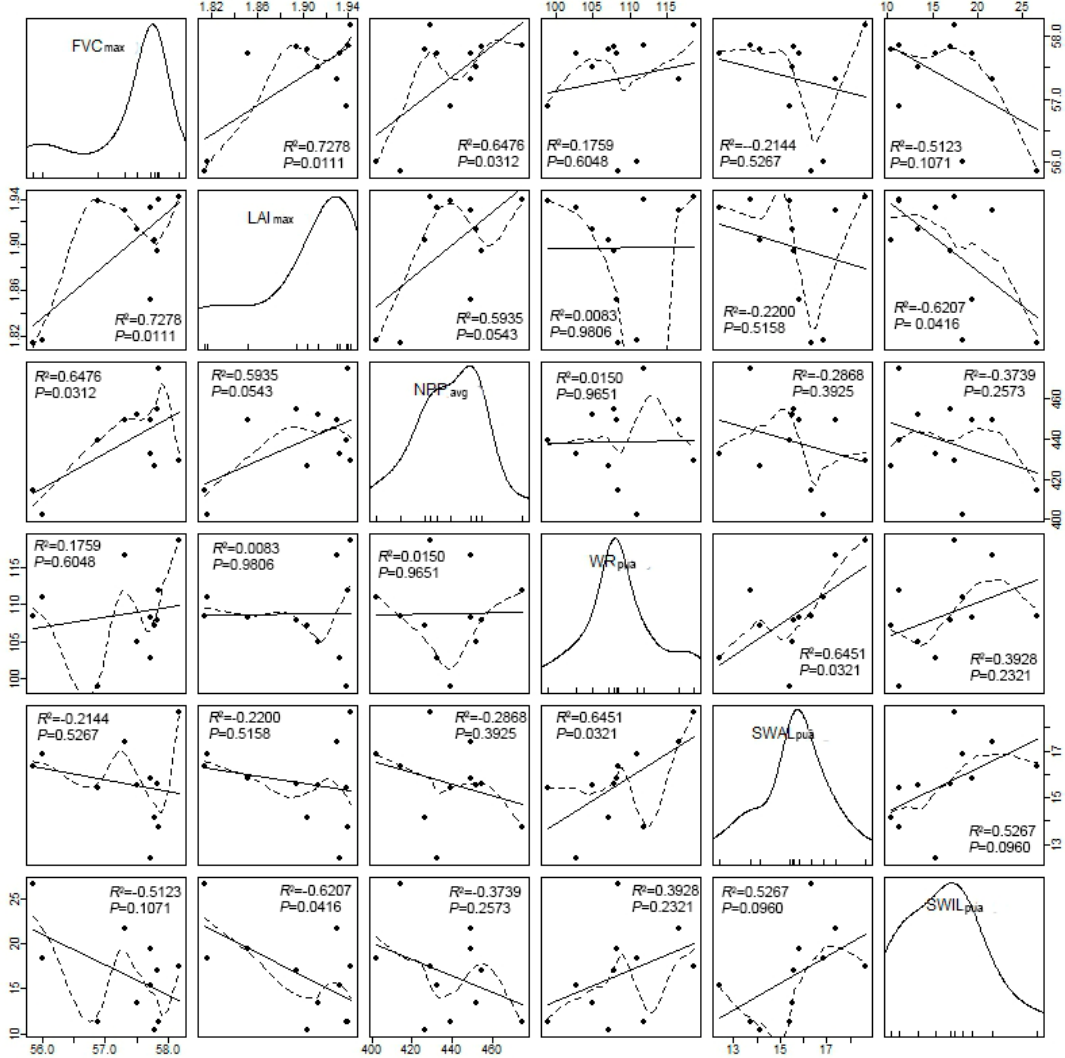
Figure 8. Tradeoffs and synergies among variables of EQ and ESs.